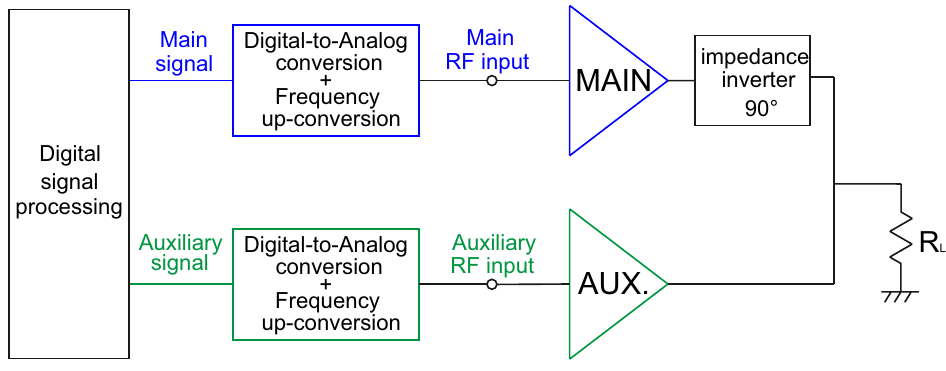
Figure 9. Digital/dual-input DPA